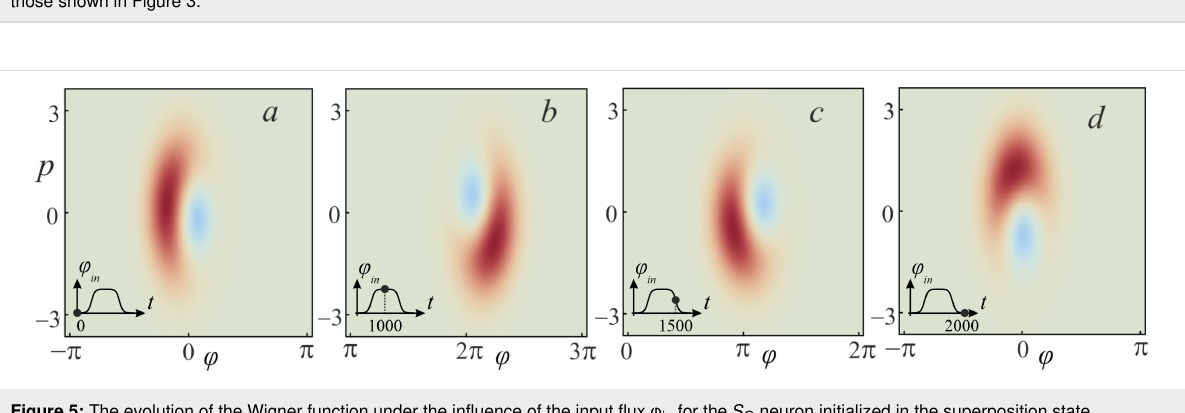
Figure 4: The Wigner functions W ( φ , p , t = 0) of the considered system initialized at the initial moment of time t = 0 (a) in the ground state ψ 0 ( φ ,0), (b) in the first excited state ψ 1 ( φ ,0) and (c) in the superposition of the lowest states for l = 0.1. Other parameters are similar to those shown in Figure 3.